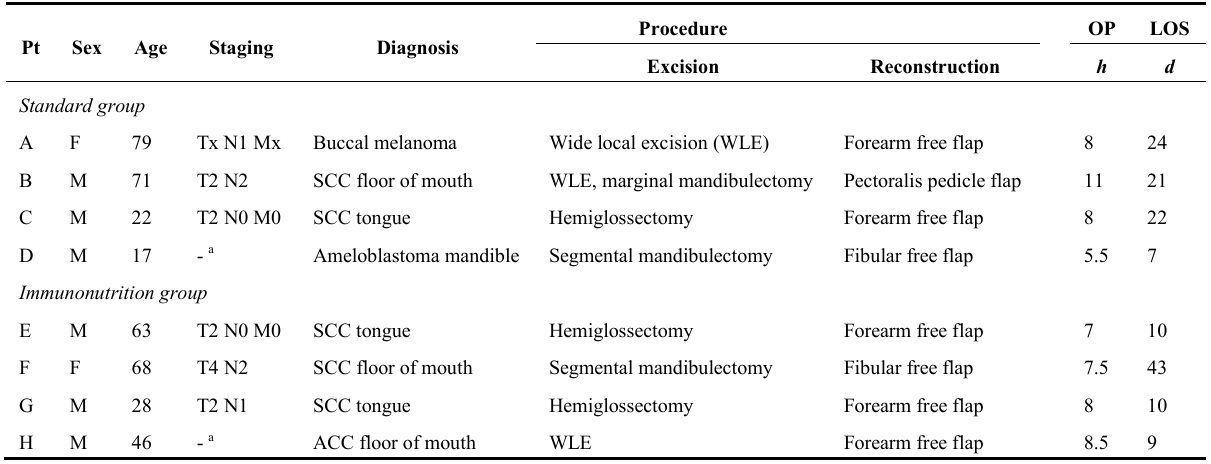
Table 2. Patient characteristics and clinical